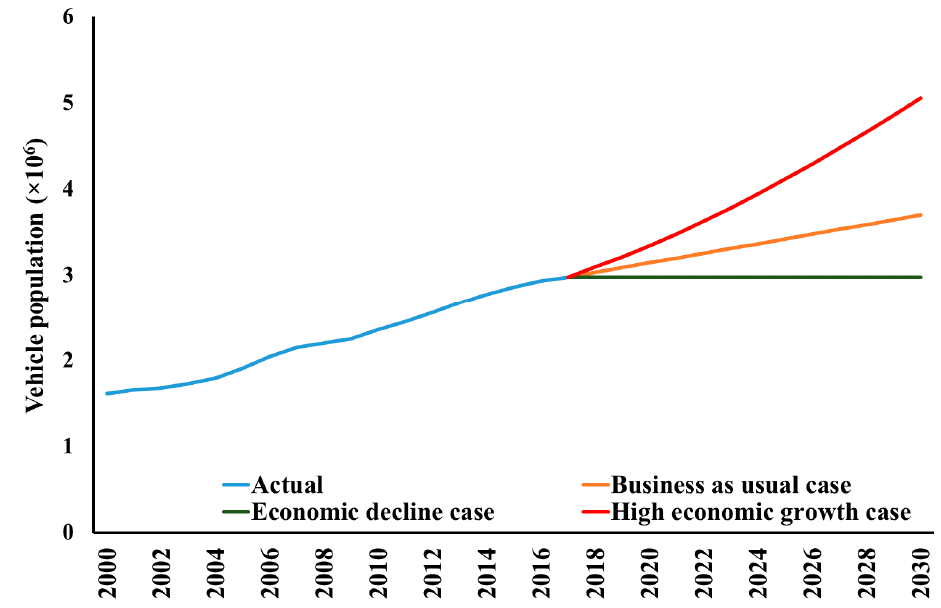
Figure 2 Figure 2. Gauteng passenger vehicle annual population estimates from 2018 to